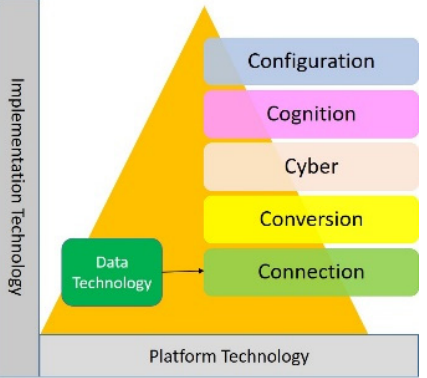
Figure 1. Location of intelligent sensing layer in the CPS manufacturing domain.